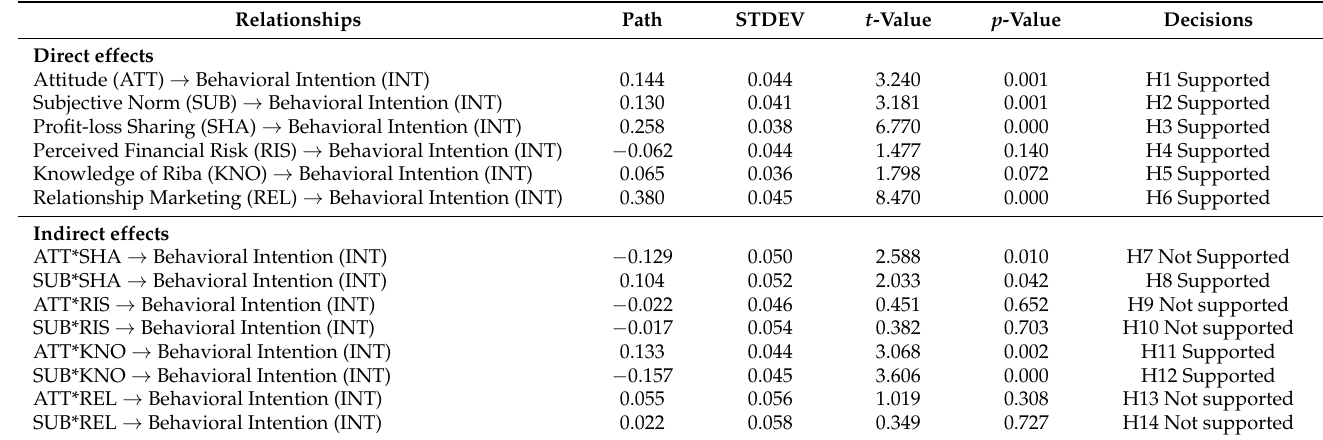
Table 4. PLS-SEM analysis for direct